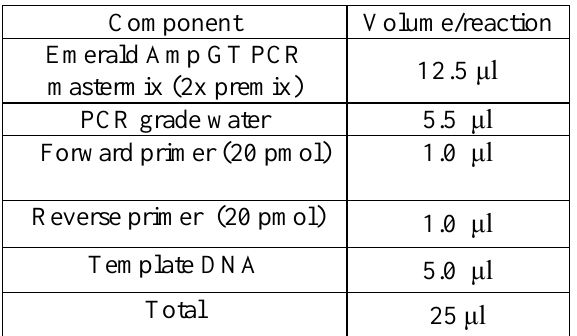
Table 1: Preparation of PCR Master Mix: